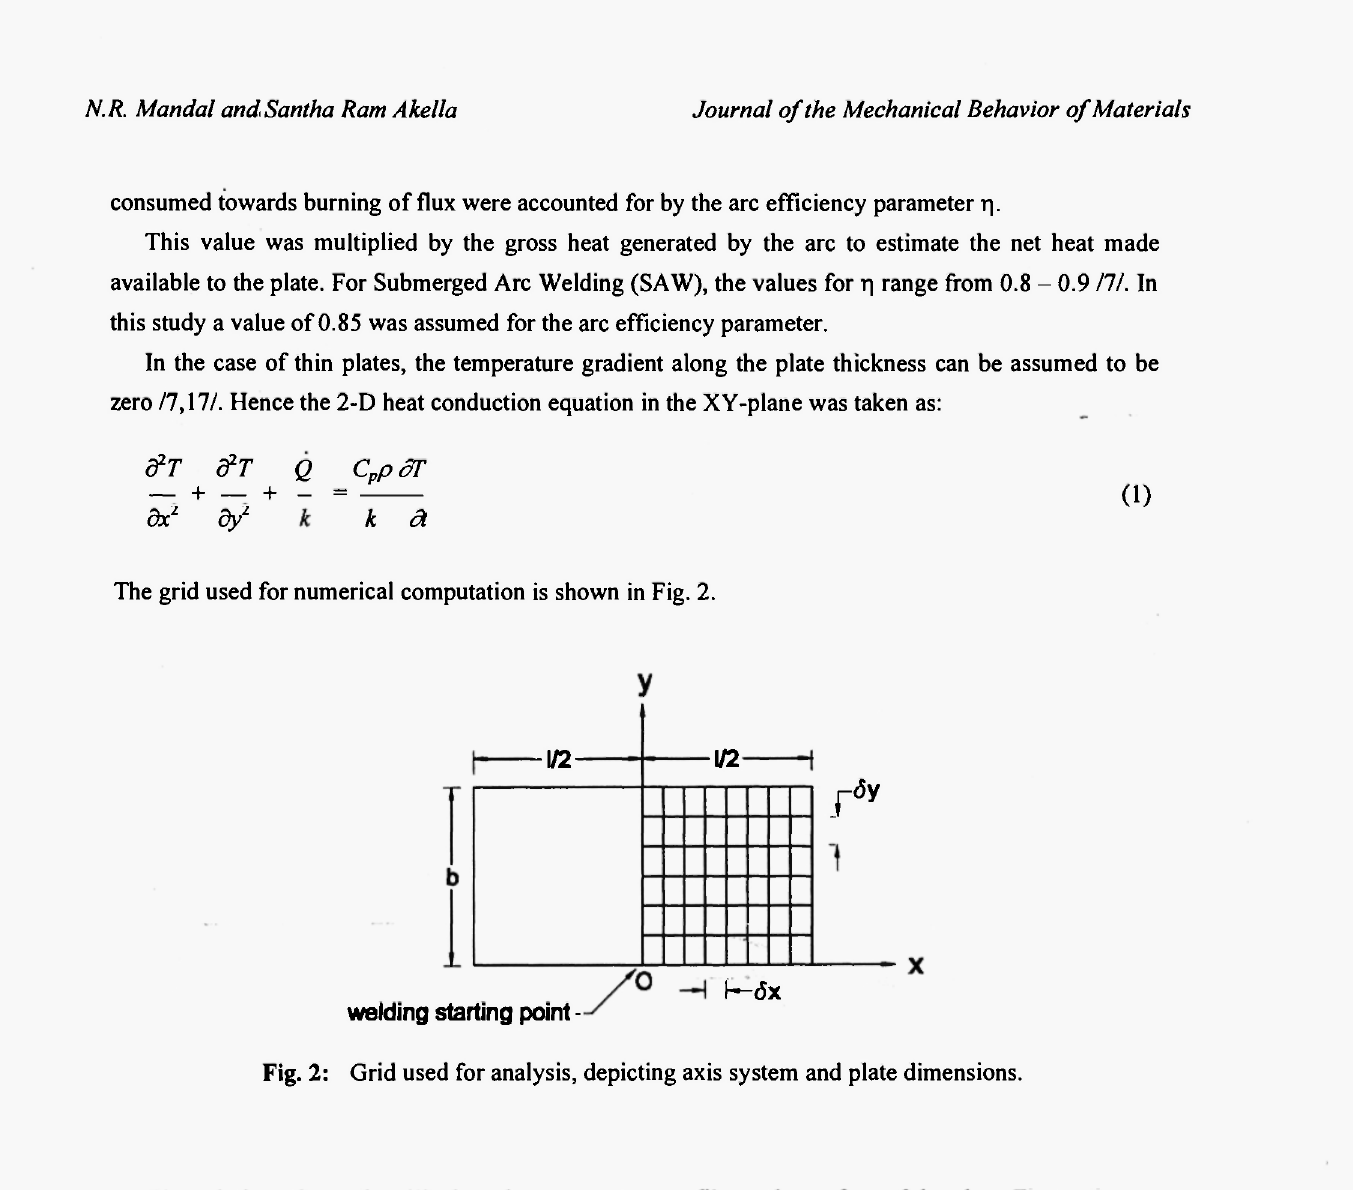
Fig. 2: Grid used for analysis, depicting axis system and plate